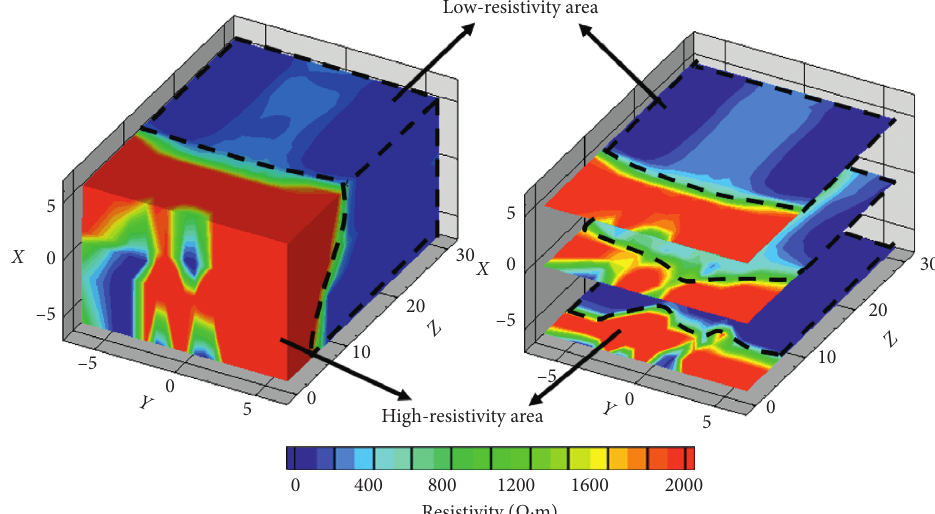
Figure 8: 3D inversion resistivity imaging results. (a) 3D image of resistivity distribution. (b) 2D slice resistivity image in three planes.